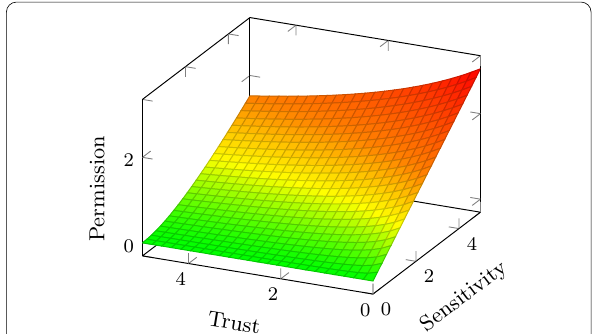
Fig. 4 Membership functions and their relationship to the final risk